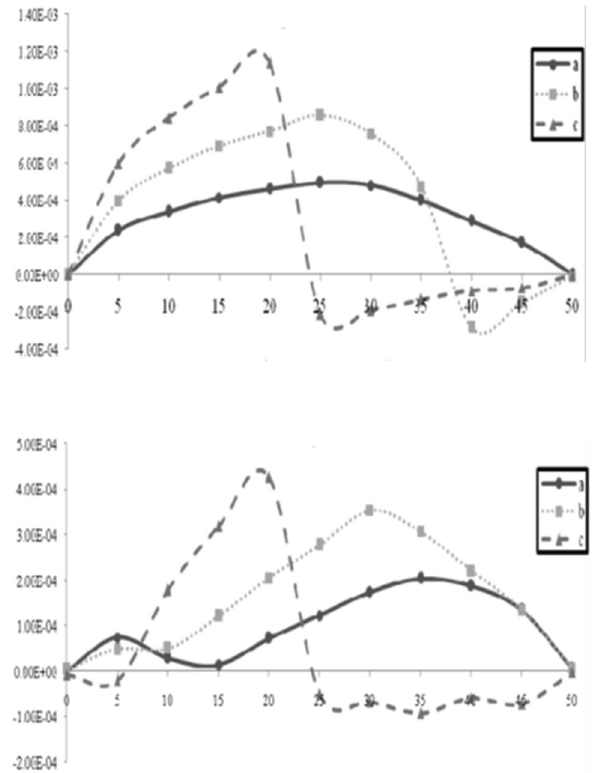
Fig. 5 Tensile and shear displacements in specified